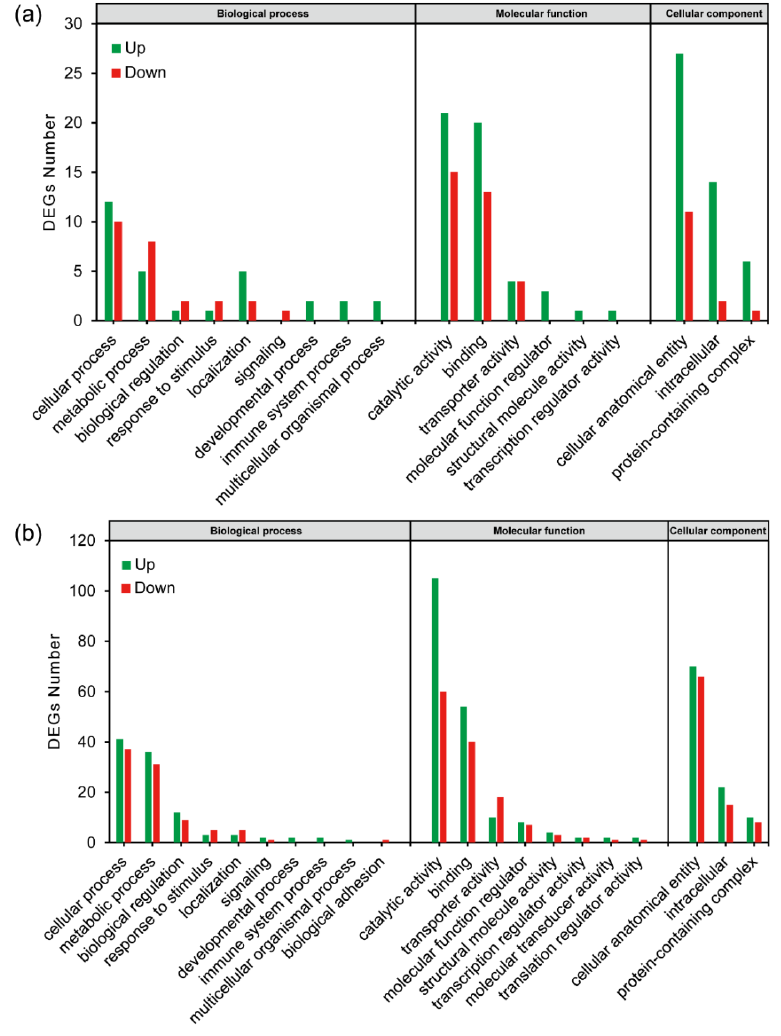
Figure 5. Gene ontology enrichment analysis of the differentially expressed genes from the cyflumetofen ‐ resistant (R_cfm) ( a ) and the bifenthrin ‐ resistant (R_bft) ( b ) strains of T. urticae .